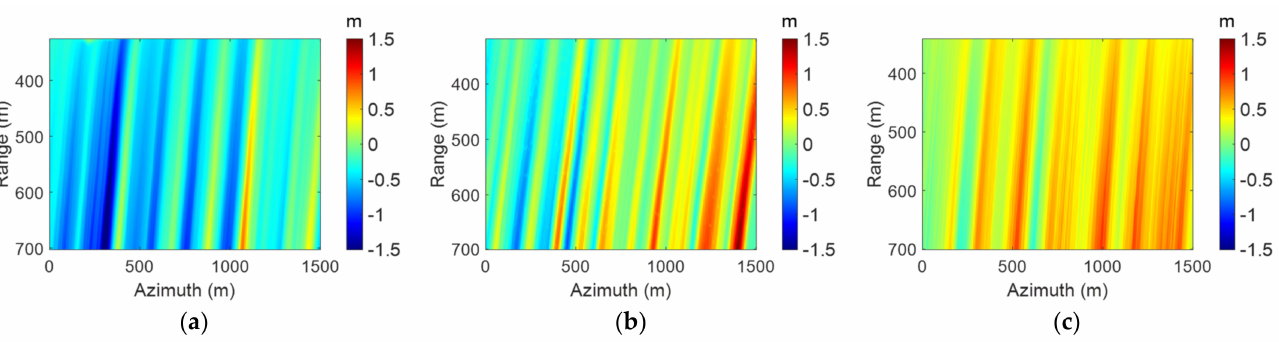
Figure 9. Position-shifting of coupling attitude altimetric errors. ( a – c ) The position-shifts along the azimuth direction (positive in the direction of flight). ( d – f ) The position-shifts along range direction (positive in the look direction) l in the images RZ14, RZ16, and RZ24.